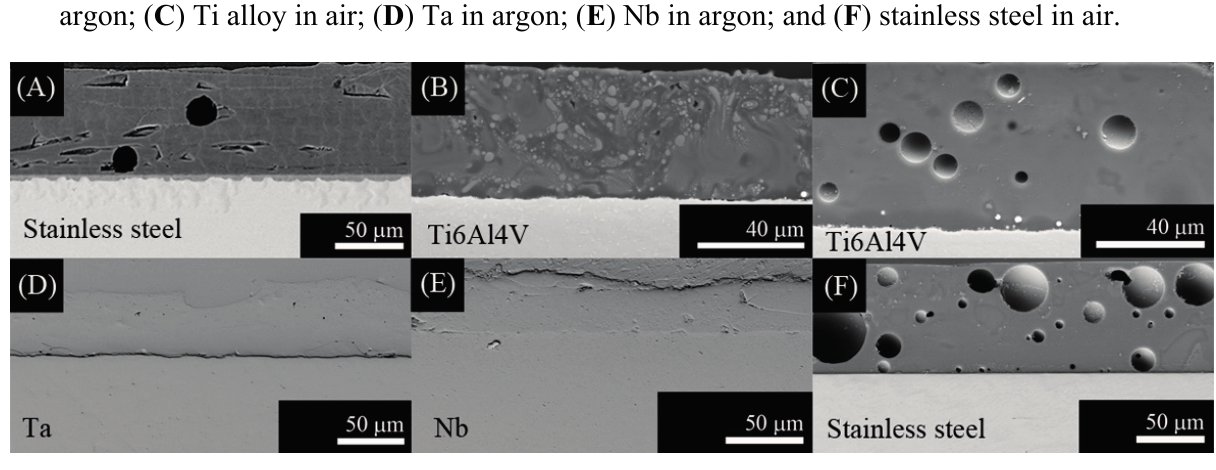
Figure 6. Scanning electronic micrographs of the cross section of the coating with ZnO35 on the following substrates: ( A ) Ti alloy in air; ( B ) Ta in argon; ( C ) Nb in argon; and ( D ) stainless steel in